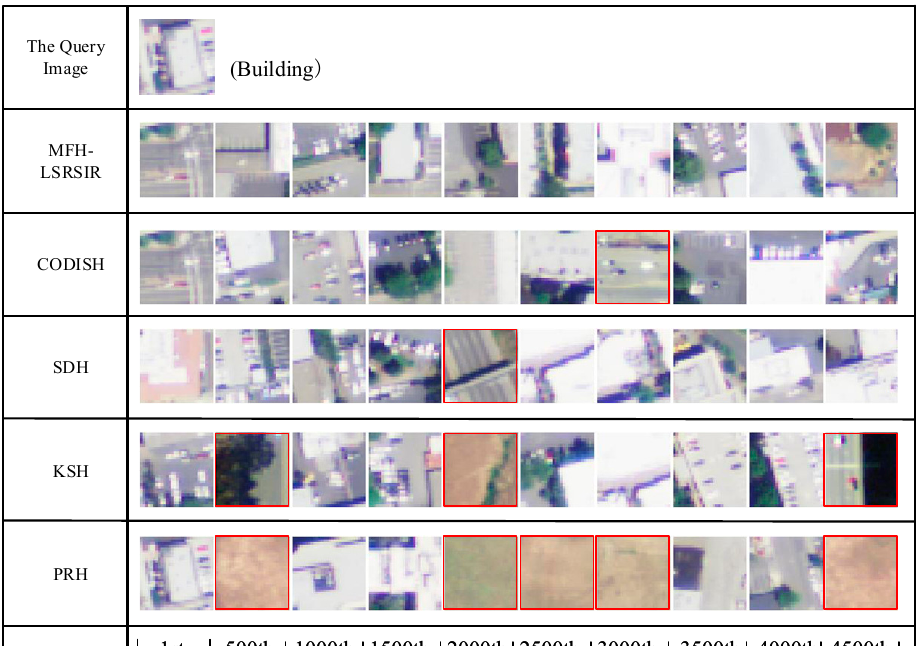
Figure 9. Visualized retrieval results on the SAT-6 dataset by different hashing methods with 64-bit hash codes. The red rectangles indicate incorrect retrieval results. The abscissa represents the sequence number of the image.